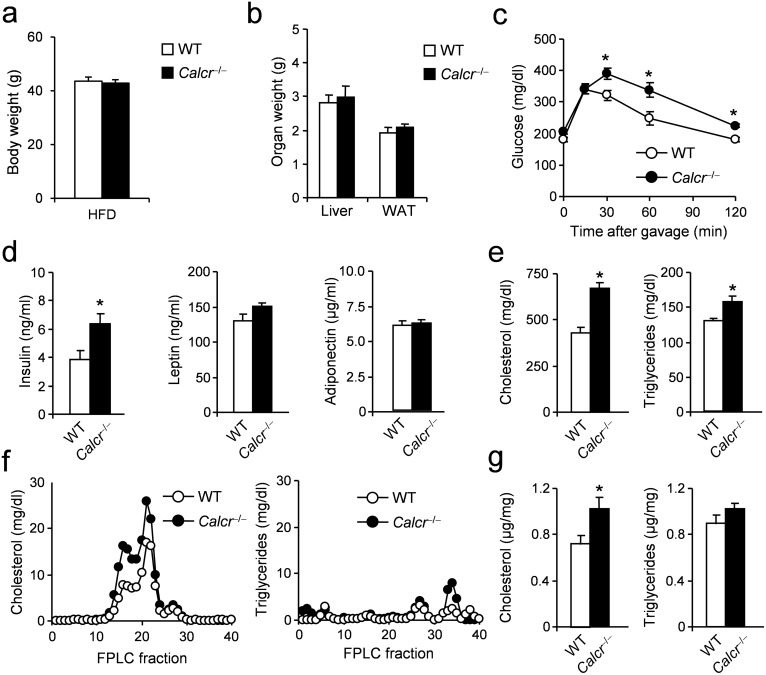
Effects of DIO on metabolic parameters in mice lacking CTR (Calcr).(a) Body weight in CTR-deficient mice and controls fed HFD for 16 weeks. (b) Organ weights (epididymal WAT, white adipose tissue) after 16 weeks of feeding. (c) Plasma glucose concentrations during OGTT (1 g/kg) following a 4h fasting period in CTR-deficient mice and controls after 16 weeks of feeding. (d) Plasma levels of insulin, leptin and adiponectin in the same mice. (e) Total plasma cholesterol and triglycerides concentrations in the same mice. (f) Cholesterol and triglycerides FPLC profile from pooled plasma (n>8) in CTR-deficient mice and controls fed HFD for 16 weeks. (g) Total hepatic cholesterol and triglycerides concentrations in CTR-deficient mice and controls fed HFD for 16 weeks. Results are shown as means ± SEM (n = 8–10). *P < 0.05.